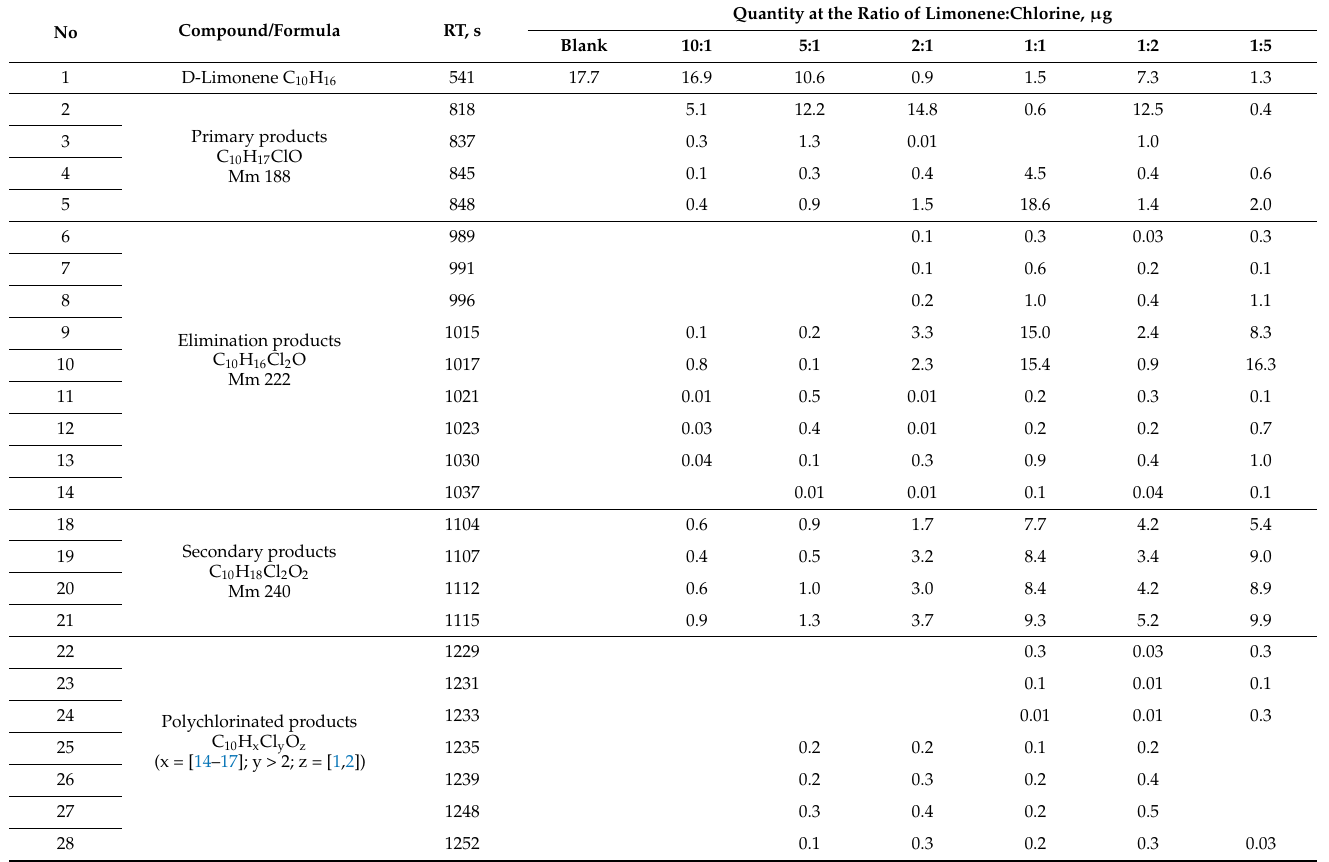
Figure 7. TIC chromatogram segment demonstrating four secondary products of limonene aqueous chlorination. Table 1. Main products of limonene transformation in conditions of aqueous chlorination with sodium